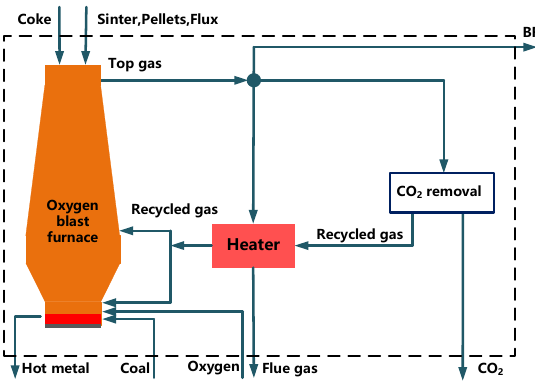
Figure 1. The flow diagram of top gas recycling-oxygen blast furnace (TGR-OBF) ironmaking process.